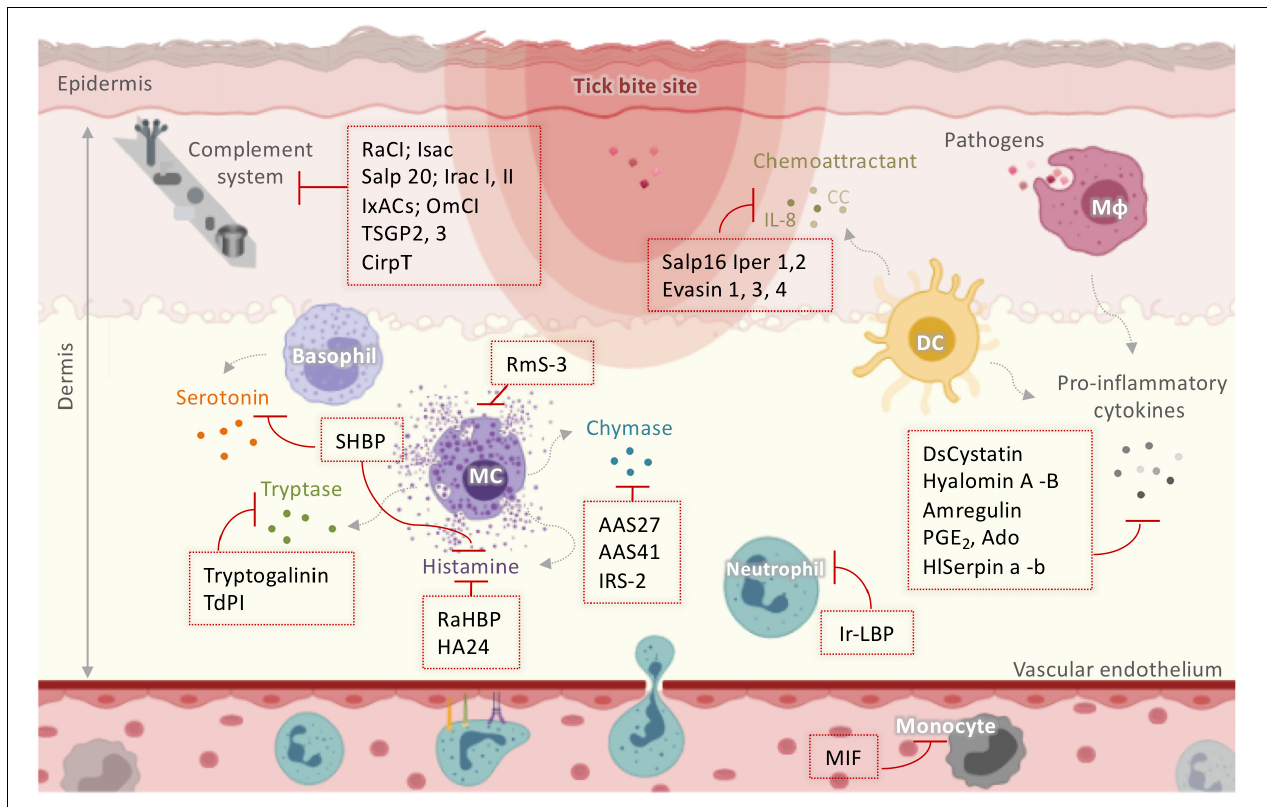
FIGURE 2 | Schematic representation of tick salivary molecules implicated in the modulation of the complement system and innate immunity. Activated resident cells in the dermis stimulate host awareness of injury and removal of the feeding ticks. Tick saliva neutralizes itch and pain through salivary components that sequester histamine and/or serotonin (such as SHBP, Ra-HBPs, and HA24) or modulate MC function (such as RmS-3). TdPI and Tryptogalinin inhibit tryptase released by MCs. AAS27, AAS41, and IRS-2 inhibit chymase liberated by MCs. Neutrophil and monocyte recruitment is suppressed by MIF and Ir-LBP. Moreover, ticks manipulate the host cytokine network by inhibiting cytokines and chemokines using Salp16 Iper 1,2; Evasin 1, 3, 4; DsCystatin; Hyalomin-A, –B; Amregulin; PGE 2 ; Ado; and HlSerpin-a, –b. Several anti-complement molecules have been identified in tick salivary glands including RaCI; Isac; Salp 20; Irac I, II; IxACs; OmCI; TSGP2, 3; and CirpT. AAS: Amblyomma americanum serpin; DC: dendritic cells; IL: interleukin; Irac: I. ricinus anticomplement; IRS-2: I. ricinus Serpin-2; Isac: I. scapularis salivary anticomplement; IxACs: Ixodes anticomplement proteins; MIF: macrophage migration inhibitory factor; M ϕ : macrophage; OmCI: O. moubata complement inhibitor; PGE 2 : prostaglandin E2; Ra-HBPs: R. appendiculatus histamine-binding proteins; RmS: Rhipicephalus microplus serpin; Salp: salivary protein; SHBP: serotonin- and histamine-binding protein; TdPI: tick-derived protease